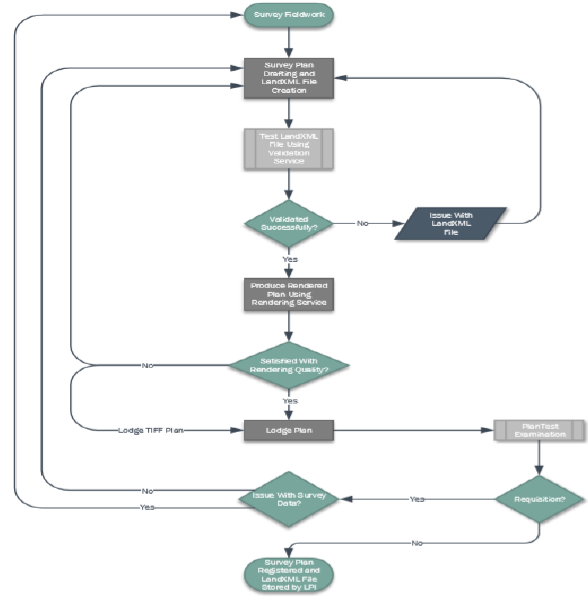
Figure 2: Method of Lodgement (EI-Kiki,